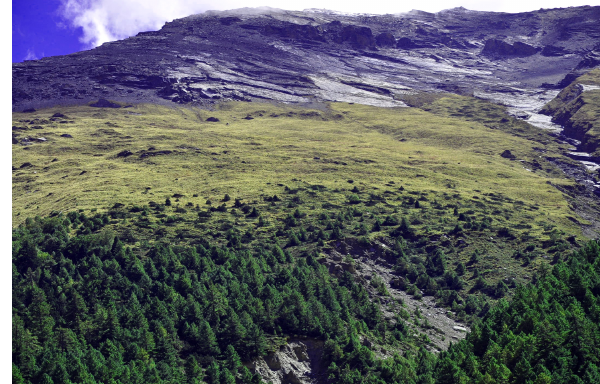
Figure 3. South-facing treeline with Pinus wallichiana and Junipe- rus indica at ca. 4100m, Manang, Nepal (Schickhoff, 21 September